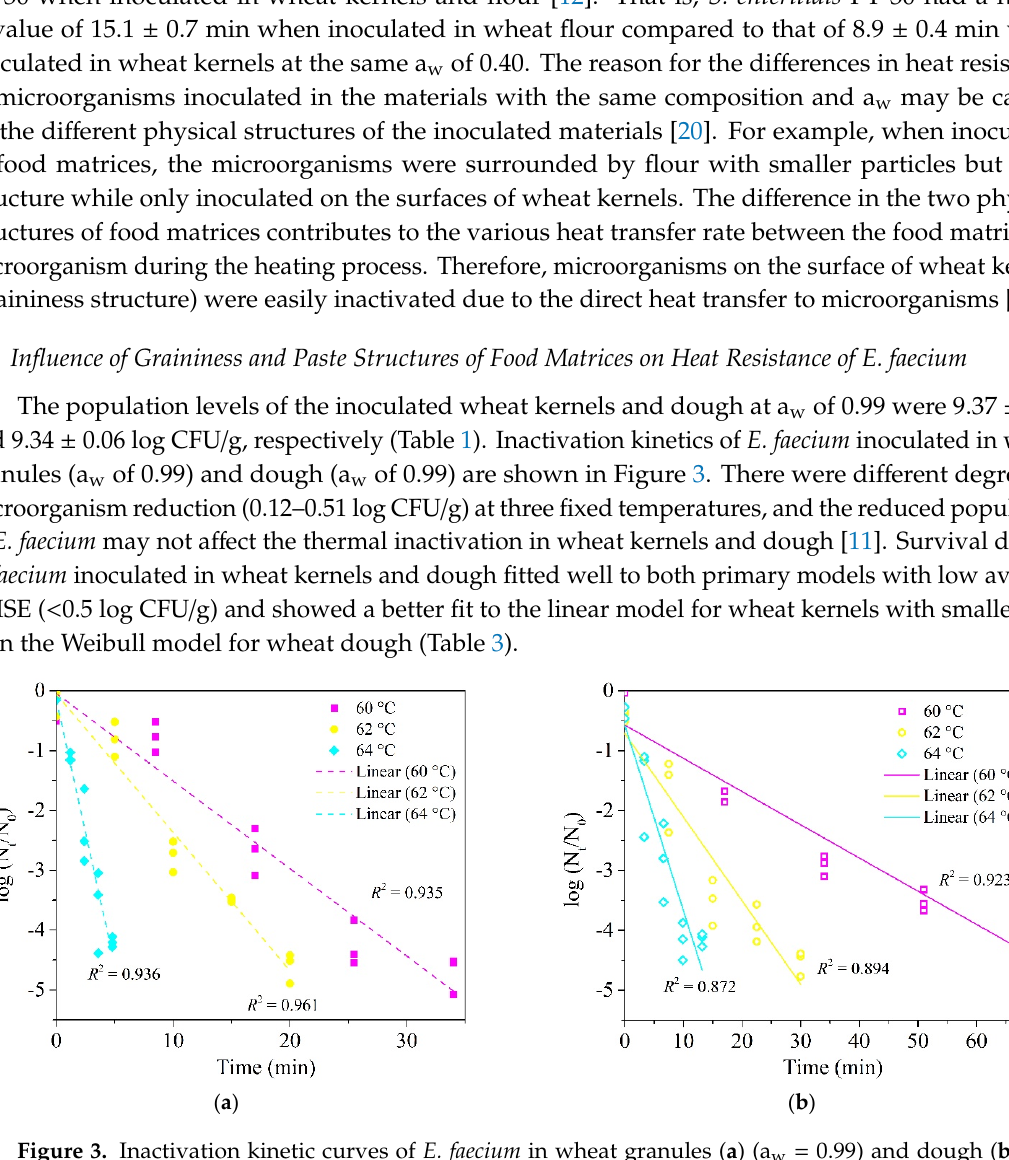
Figure 3. Inactivation kinetic curves of E. faecium in wheat granules ( a ) (a w = 0.99) and dough ( b ) (a w = 0.99) at 60, 62 and 64 °C under a fixed heating rate of 5 °C/min in the HBS.